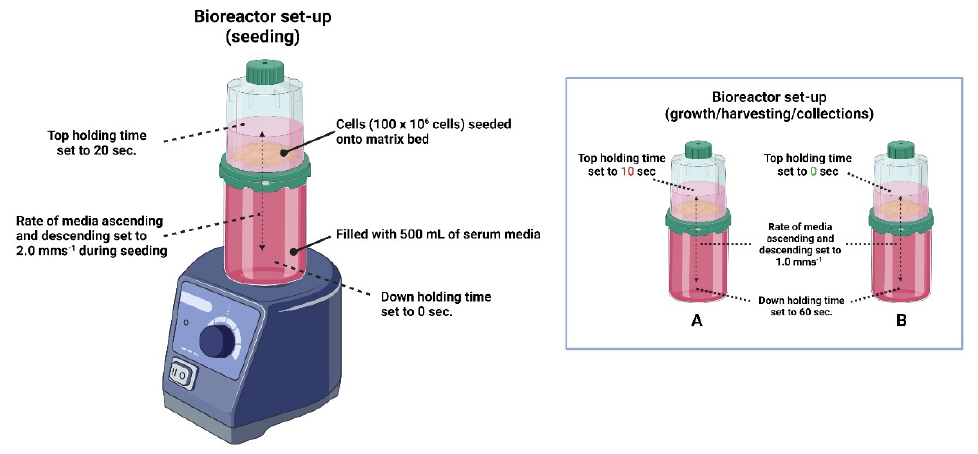
Figure 2. Schematic of bioreactor setup with different top holding times set for bioreactors A and B. Created with Biorender.com (accessed on December 21, 2021).